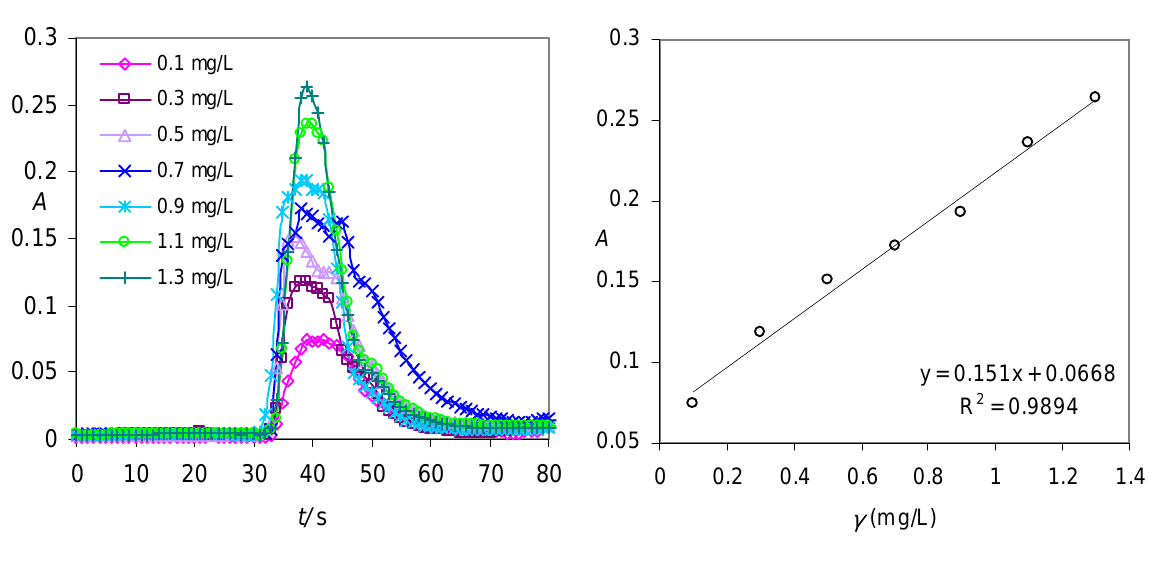
Figure 12. FIAgrams (left) and calibration line (right) obtained for calibration solutions with hydrogen phosphate concentration extending from 0.1 to 1.3